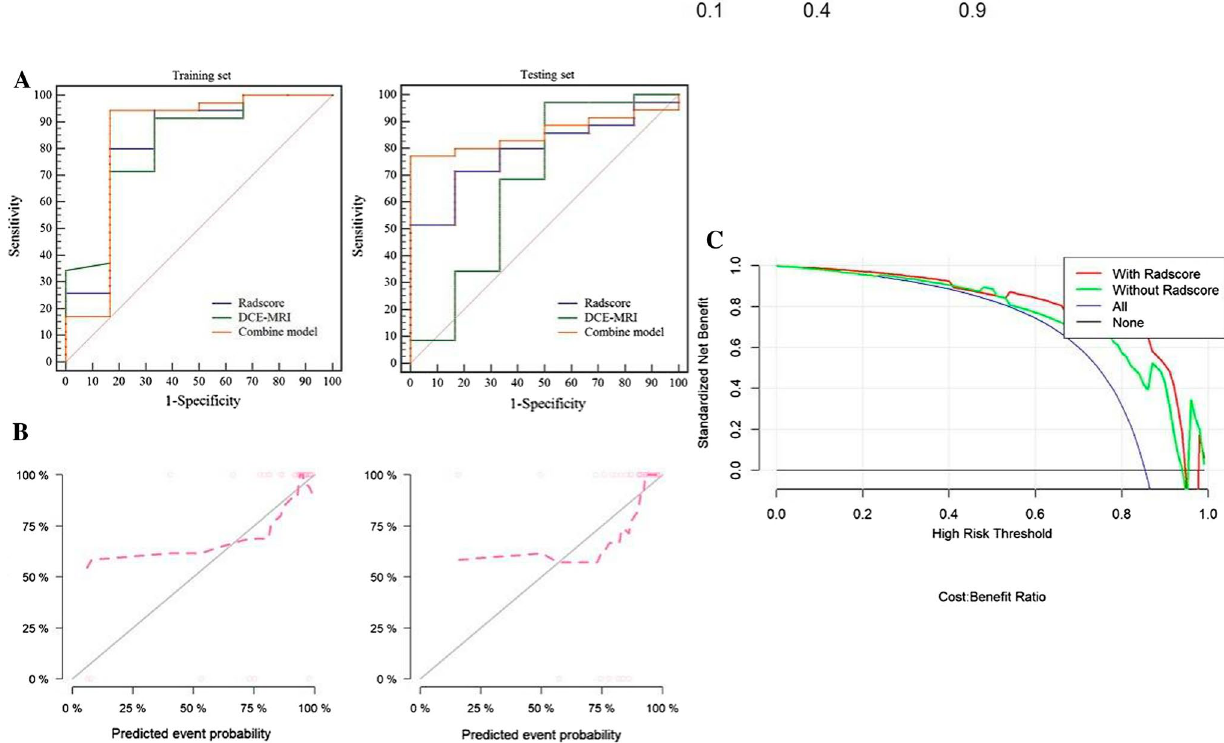
Fig. 4 Developed radiom- ics nomogram generated by combining the features acquired from LASSO and DCE-MRI. The distribution of predictors and the total points are superimposed on the nomogram scales. The density plots show the distribution of continuous variables, such as radiomics signature and total points. The patient and treatment-related character- istics were included in the